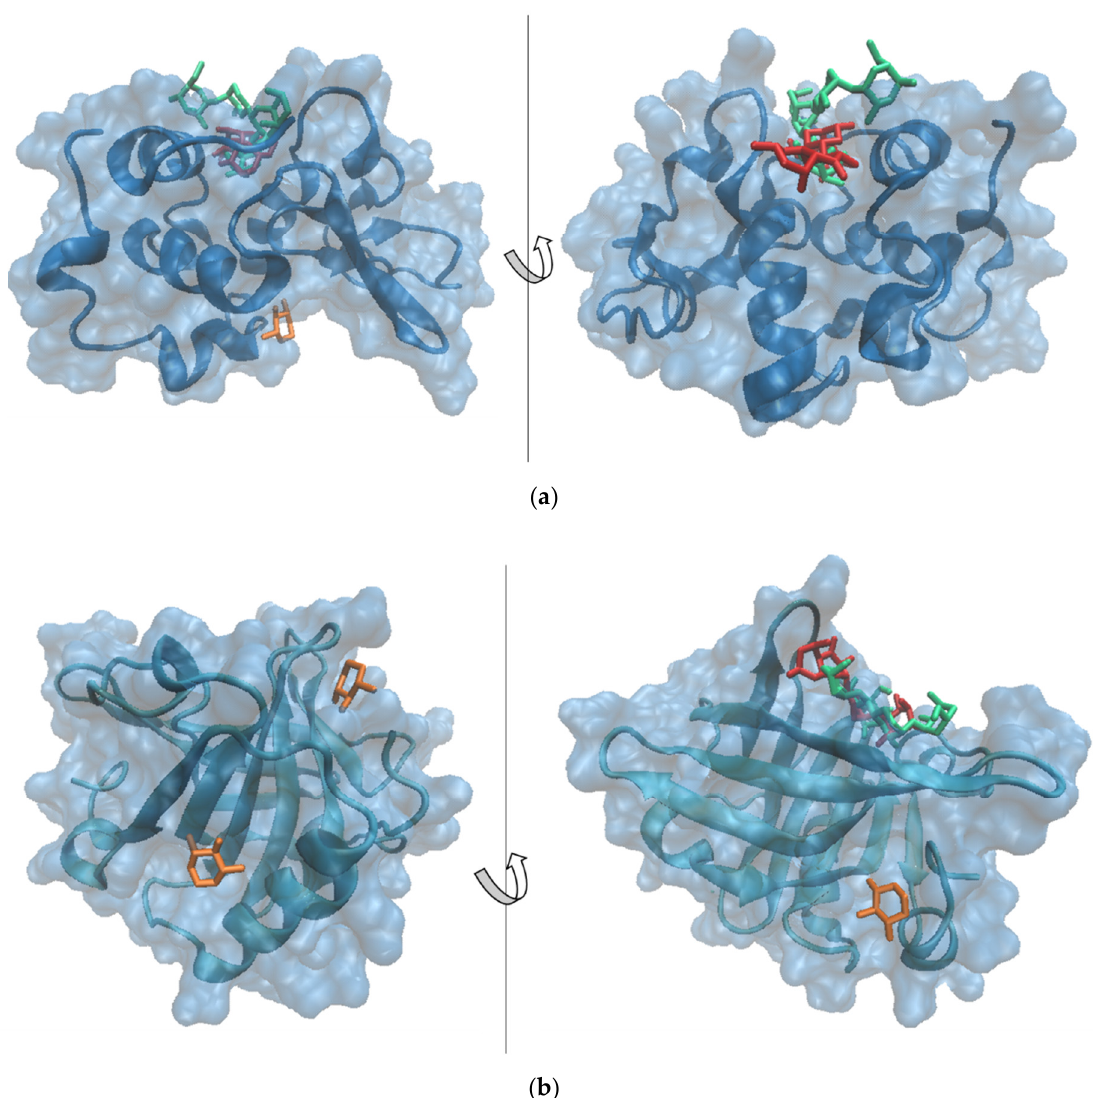
Figure 1. Superposition of the models showing the most probable complexes formed between ( a ) α-lactalbumin and ( b ) β-lactoglobulin (represented in blue in surf style) and xylose (represented in orange in licorice style—models 1 and 2), quercetin-4′- O -monoglucoside (represented in red in licorice style) and quercetin-3,4′- O -diglucoside (represented in green in licorice style). Images were prepared using VMD software [42].